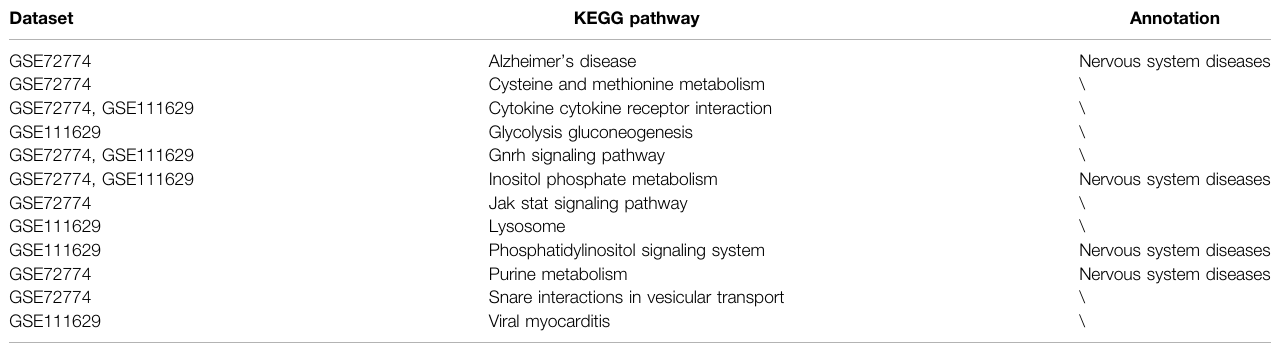
TABLE 4 | The KEGG pathway enrichment of PD-associated genes calculated by SIMPO-TSS1500.